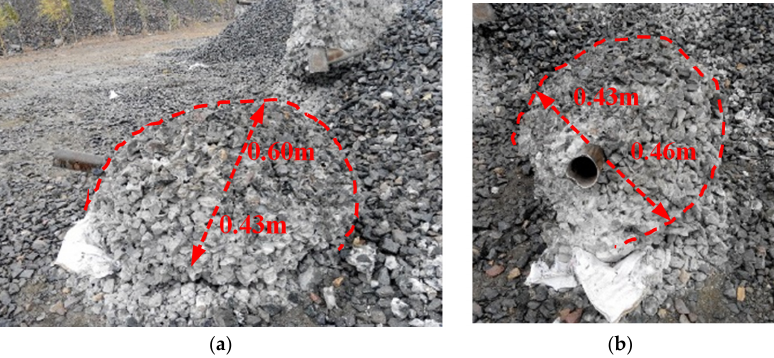
Figure 6. Concretion of C–S grout in the seemingly homogeneous loose rock mass (setting time: 18 s): ( a ) Vertical direction; ( b ) Horizontal direction.